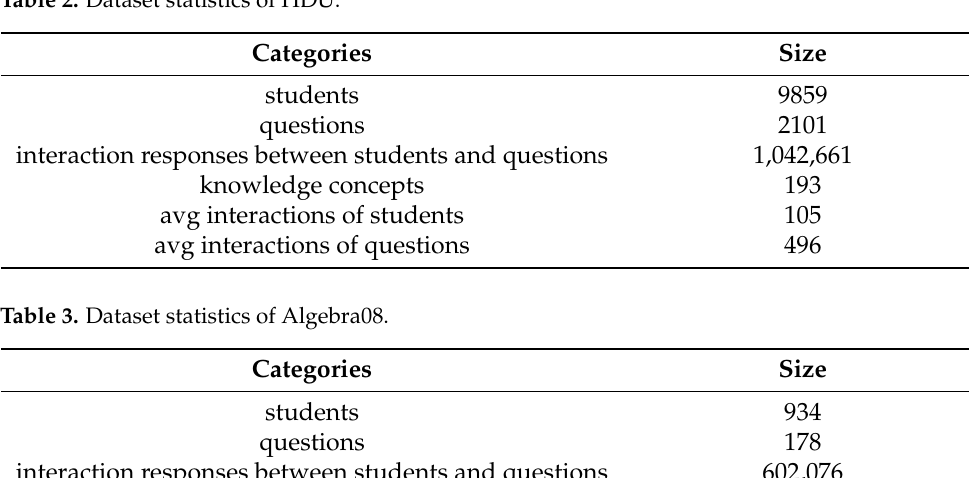
Table 2. Dataset statistics of HDU.